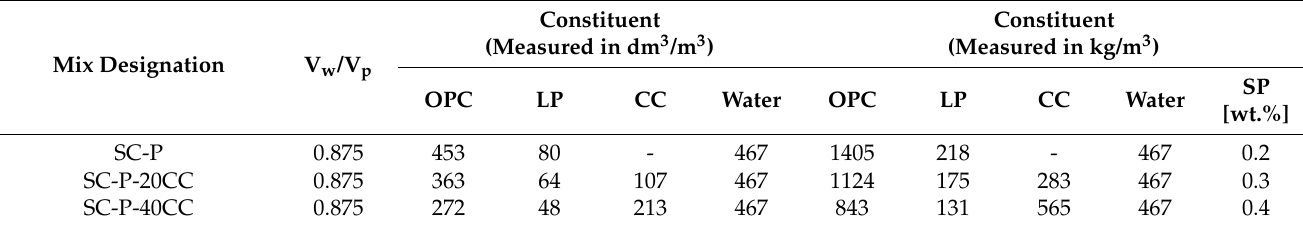
Table 3. Proportioning of the paste constituents for TG and